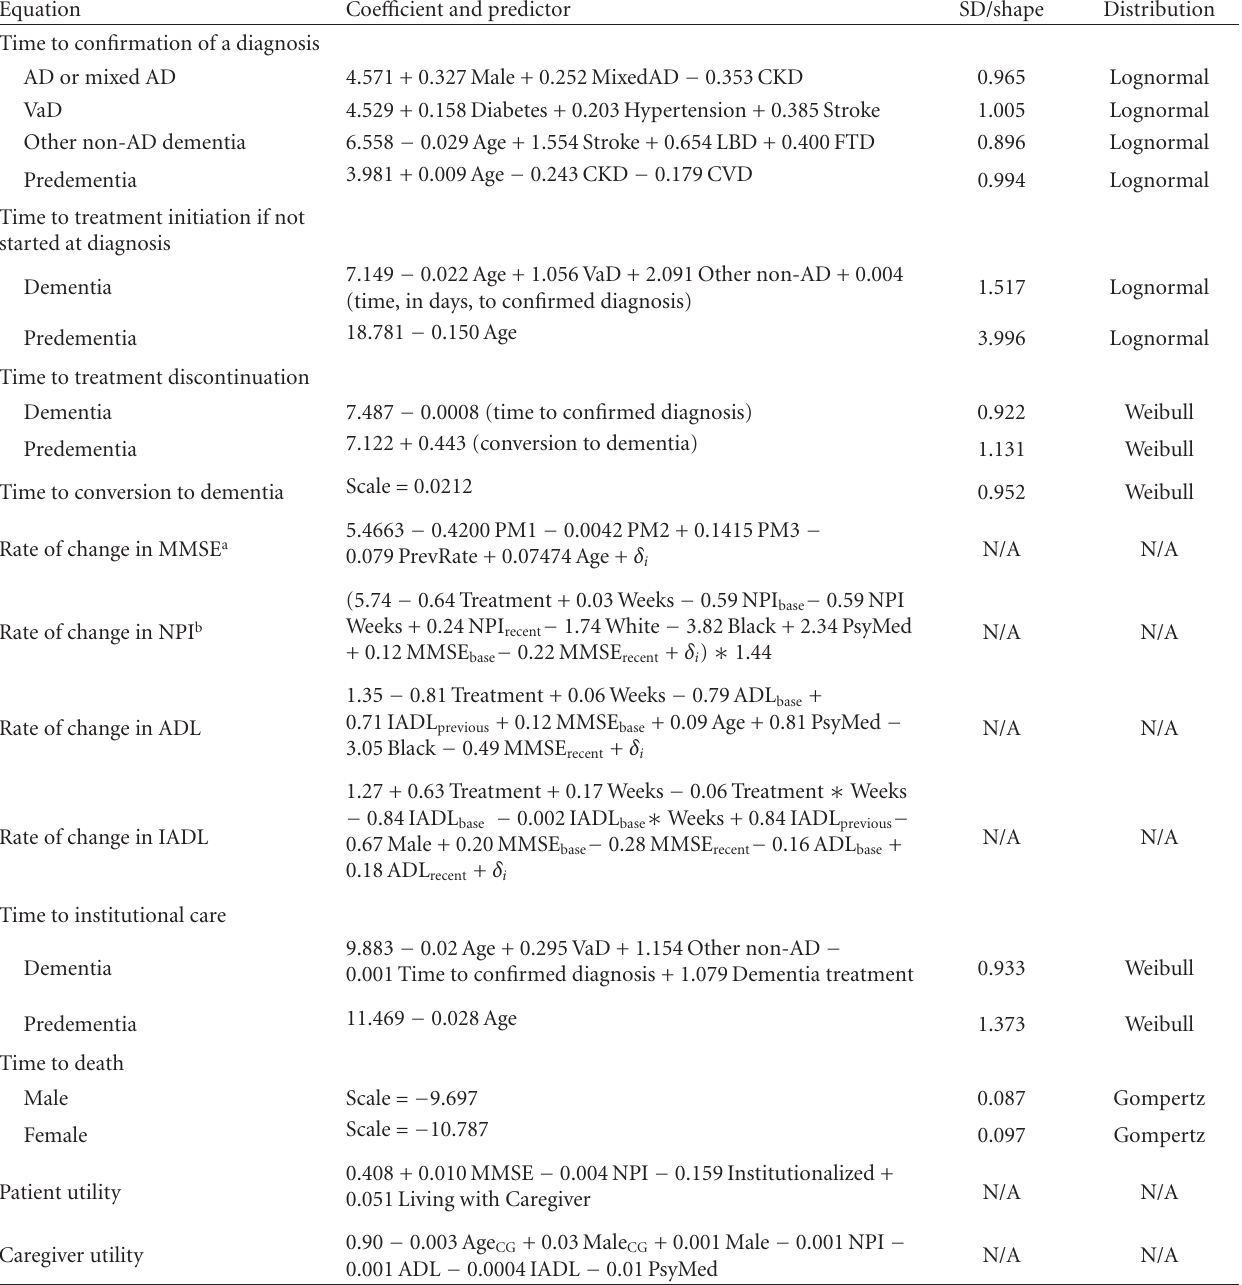
Table 2: Equations for prediction of time to events and disease